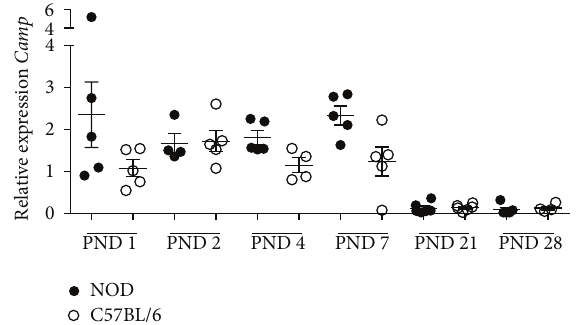
Figure 7: Relative gene expression of Camp , analyzed in intestine tissue from NOD and